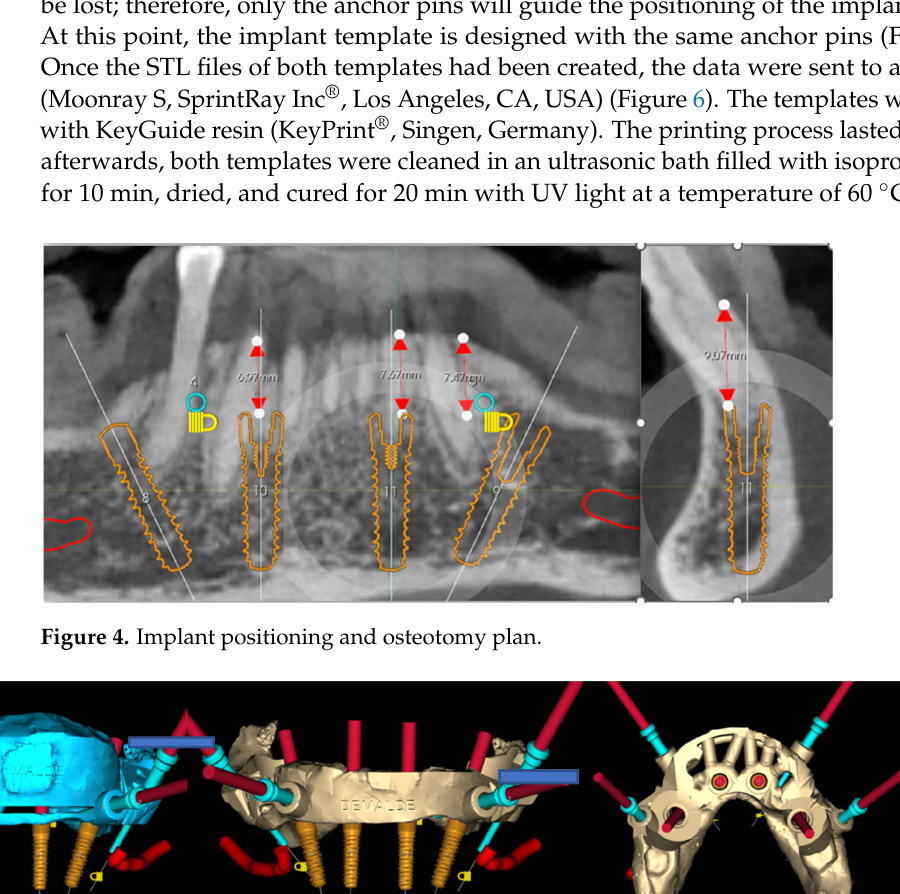
Figure 3. Digital projection of the provisional prosthesis.